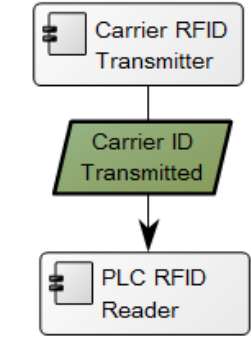
Figure 10. Integration layer